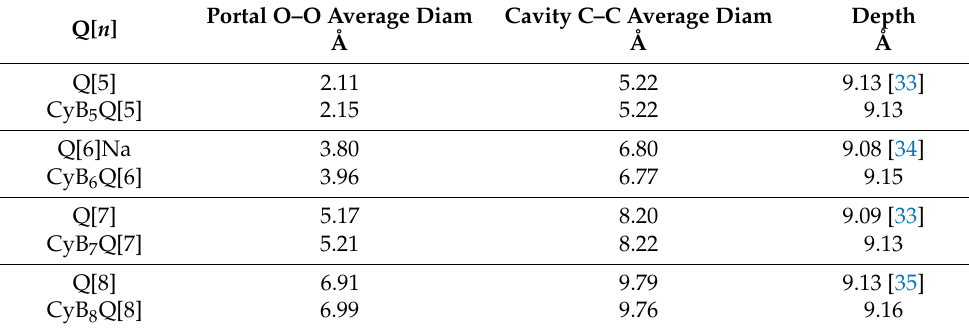
Table 1. A comparison of the dimensions of CyB5–8Q[5–8] to classical Q[5–8] derived from X-ray crystal